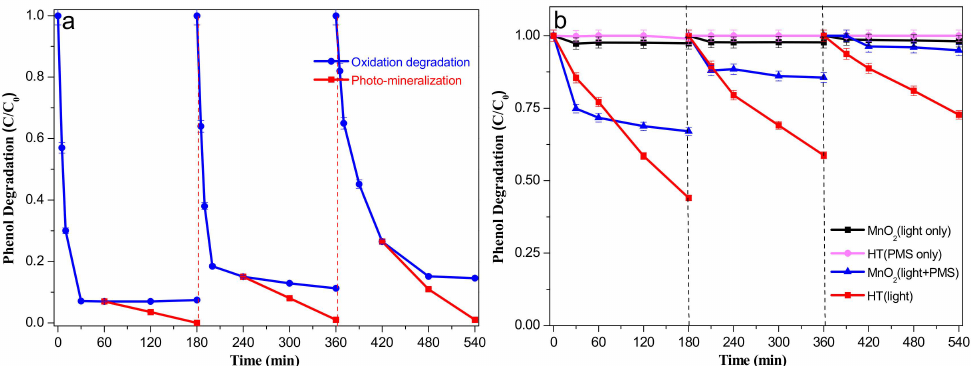
Figure 10. Recyclability of HTM spheres ( a ) and HT and MnO 2 ( b ) for phenol